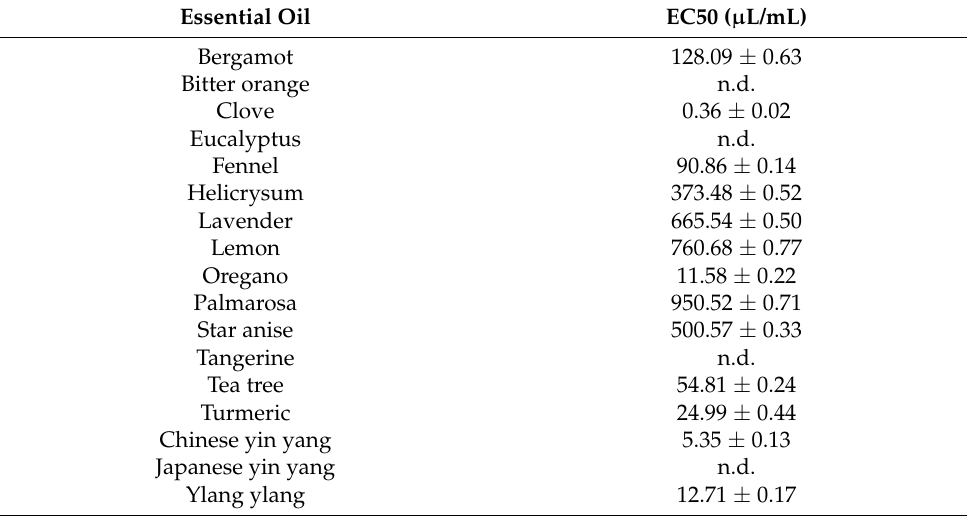
Table 2. Antioxidant activity (expressed as EC 50 ) of EOs. Essential